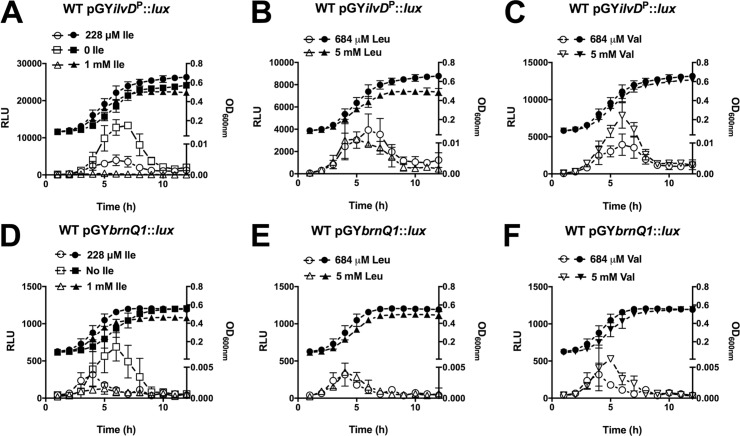
Ile is the predominant BCAA to regulate CodY activity on the brnQ1 promoter.A-F) WT S. aureus containing the lux reporter vector with either A-C) the partial ilvD promoter region (pGYilvDP::lux) or B) the complete brnQ1 promoter region (pGYbrnQ1::lux) was pre-grown in complete CDM to mid-exponential phase and then sub-cultured into either complete CDM (284 μM, 684 μM Leu, 684 μM Val) or CDM with limiting/excess concentrations of BCAAs, as indicated. Luminescence (left axis, open shapes) and OD600nm (right axis, filled shapes) were read hourly. Data are the mean +/- SD of three biological replicates.